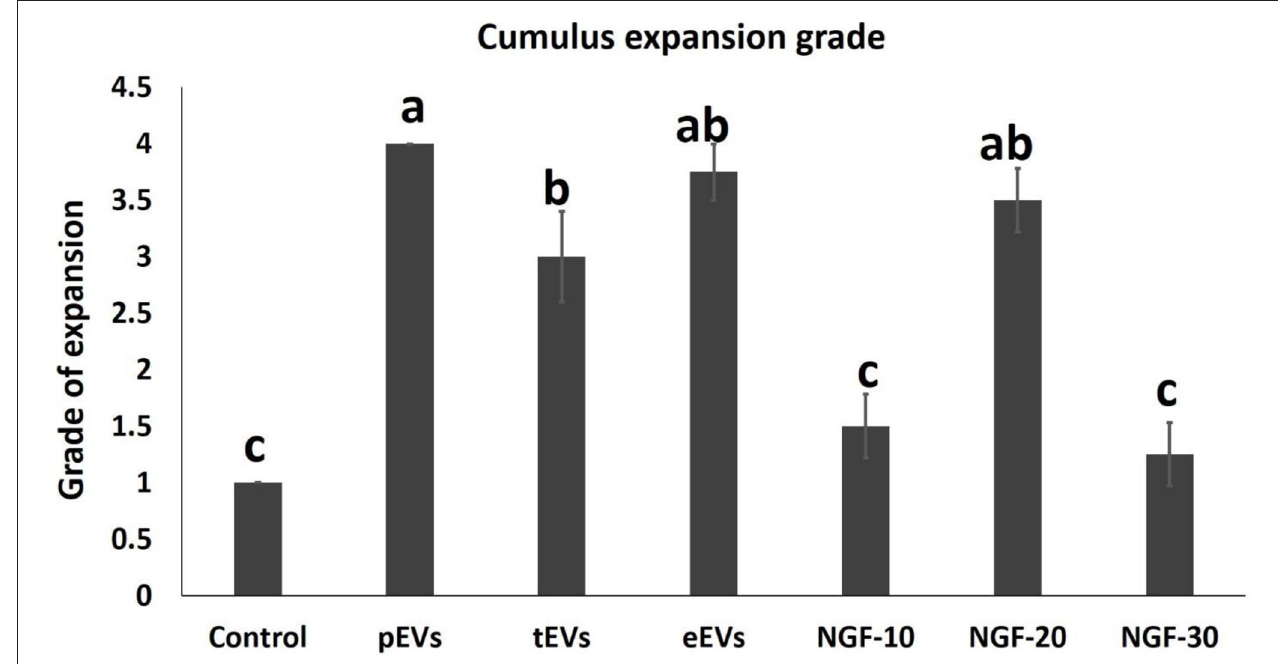
FIGURE 4 | Comparison between the values of the different degrees of cumulus expansion in experimental groups. Different letters ( a – c ) indicate a significant difference at p < 0.05.